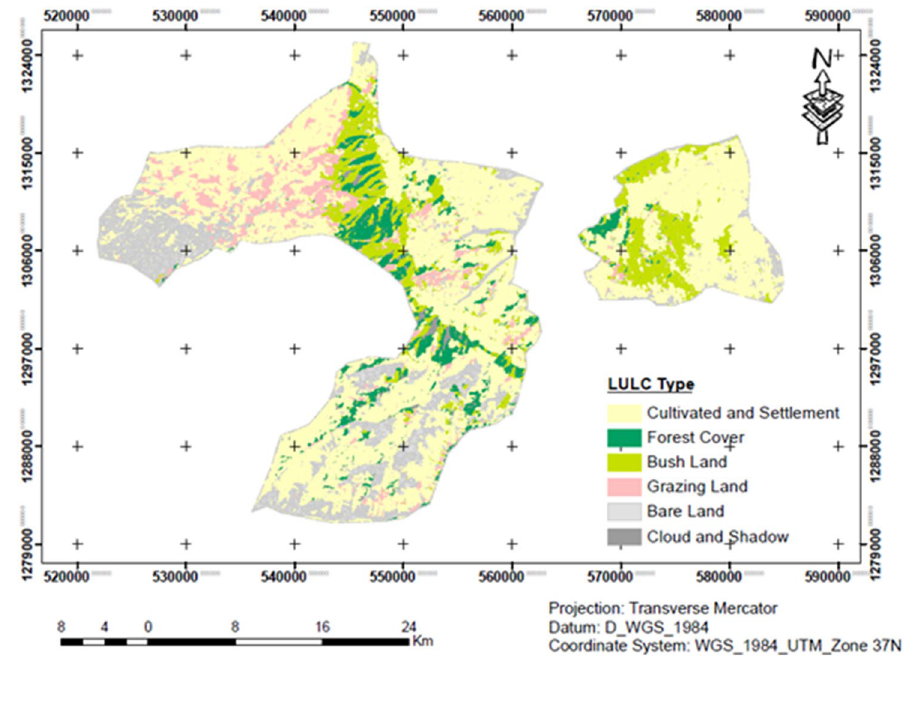
Fig. 3 LULC map of Gubalafto District in